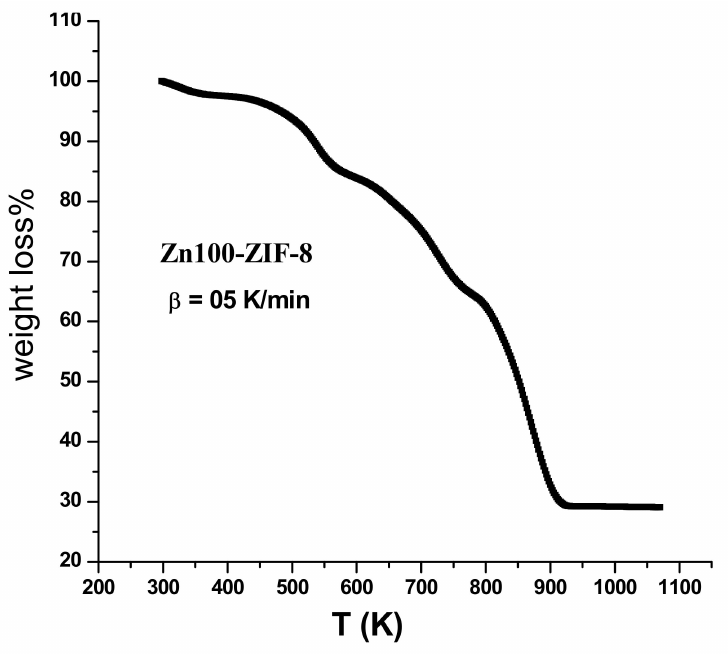
Figure 1. TGA curves for Zn100-ZIF-8 at heating rate 5